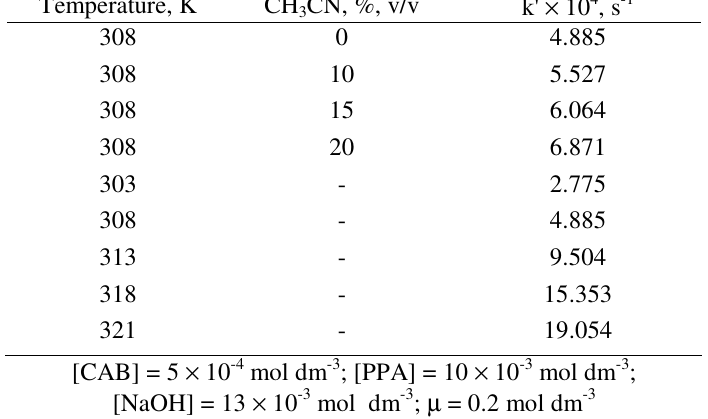
Table 2 . Effect of varying temperature and dielectric permittivity on the rate